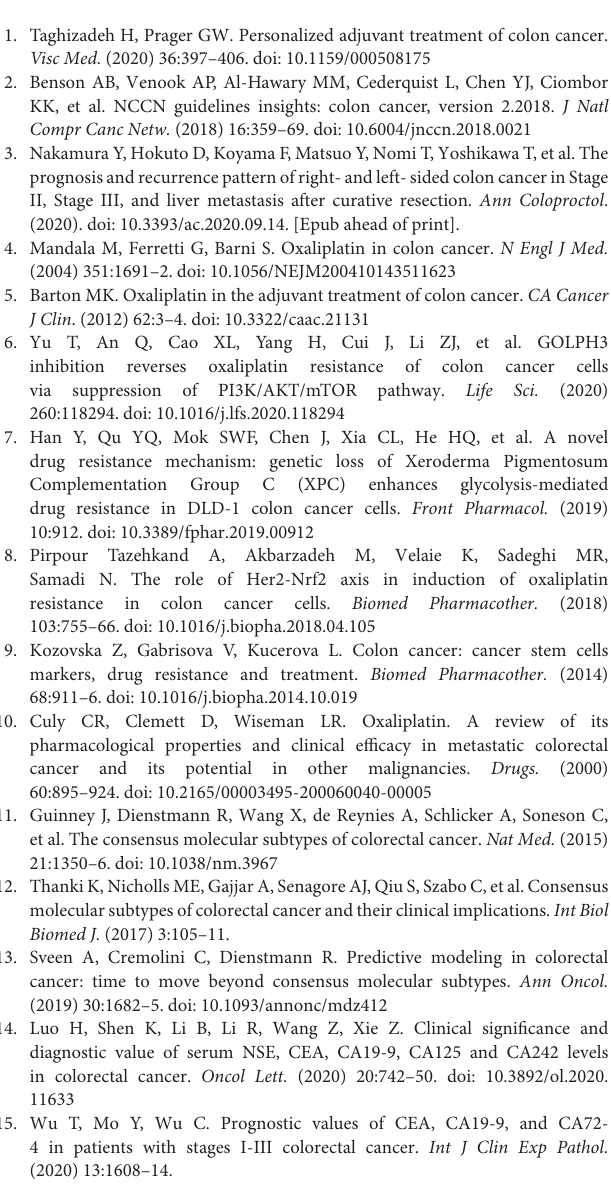
Supplementary Table 1 | DEGs between oxaliplatin-resistant and -sensitive colon cancer cells.